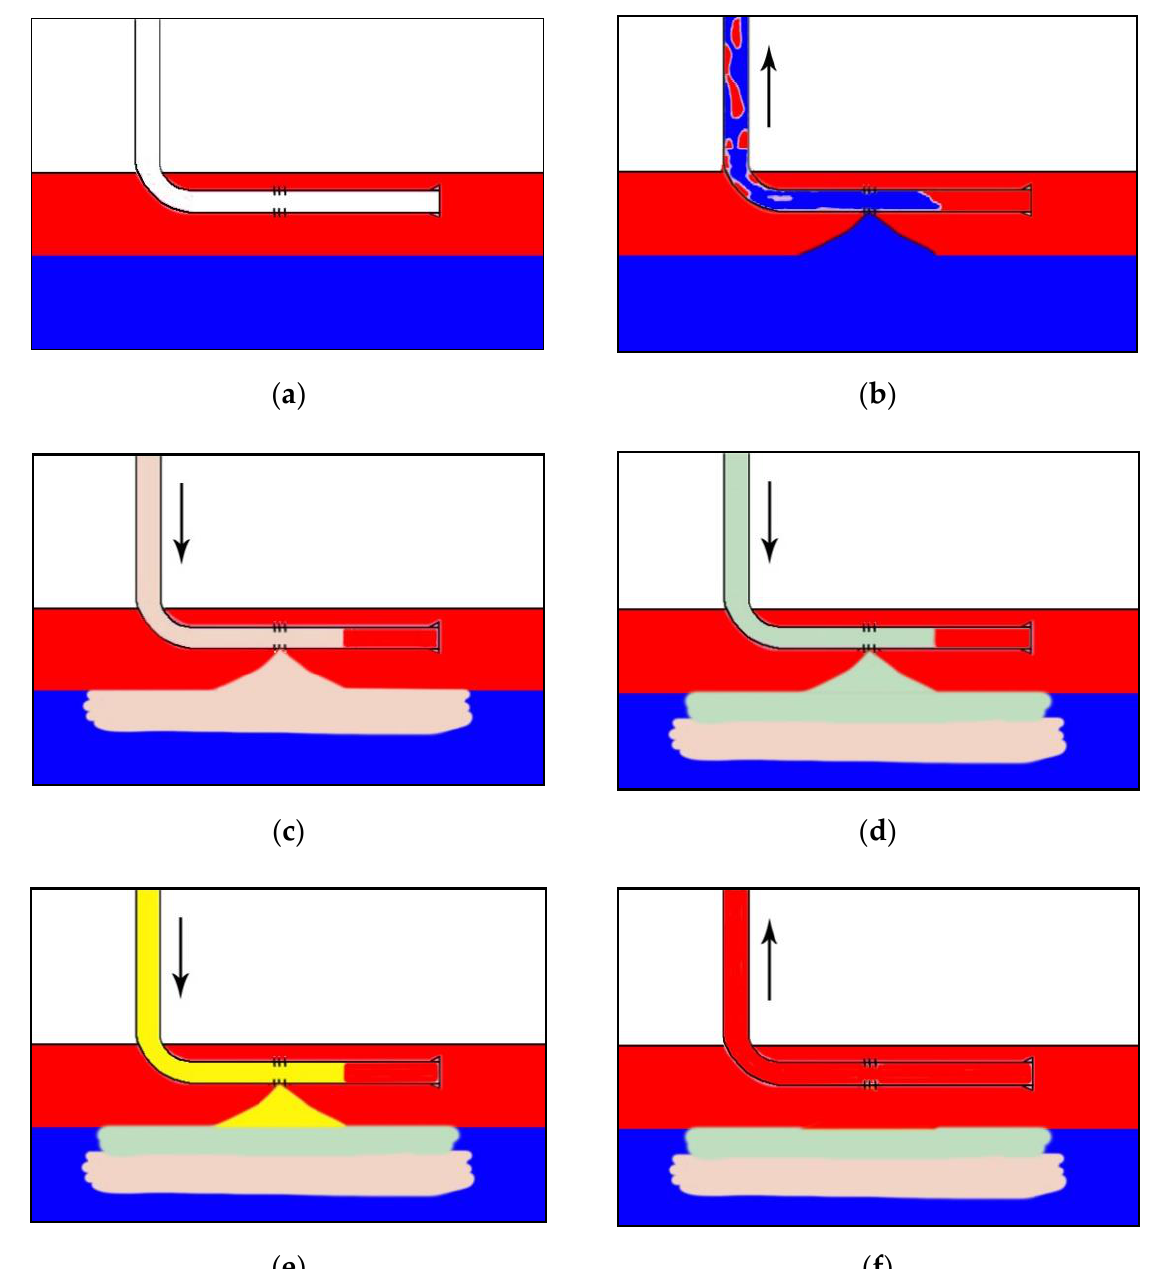
Figure 4. Schematic of polymer gel for controlling bottom-water coning in horizontal well: ( a ) res- ervoir with bottom water; ( b ) bottom water coning; ( c ) injecting high-density brine; ( d ) injecting the gelants; ( e ) injecting displacement fluid; (f) restarting well production: oil layer; aquifer; high-density brine; gelant; displacement fluid.